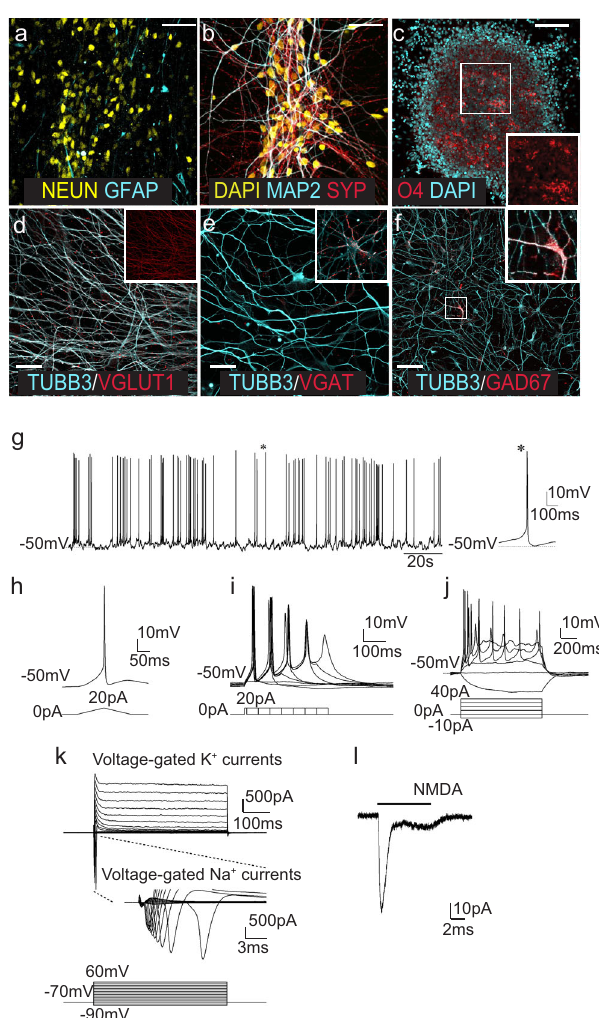
Fig. 2 cNESCs are multipotent. a cNESCs (1.53E) differentiate to NEUN positive neurons and GFAP positive astrocytes. The experiment was repeated with 3 biologically independent cell lines. Scalebar: 20 μ m. b Mature MAP2 positive neurons express Synaptophysin (SYP) by day 30. The experiment was repeated with 3 biologically independent cell